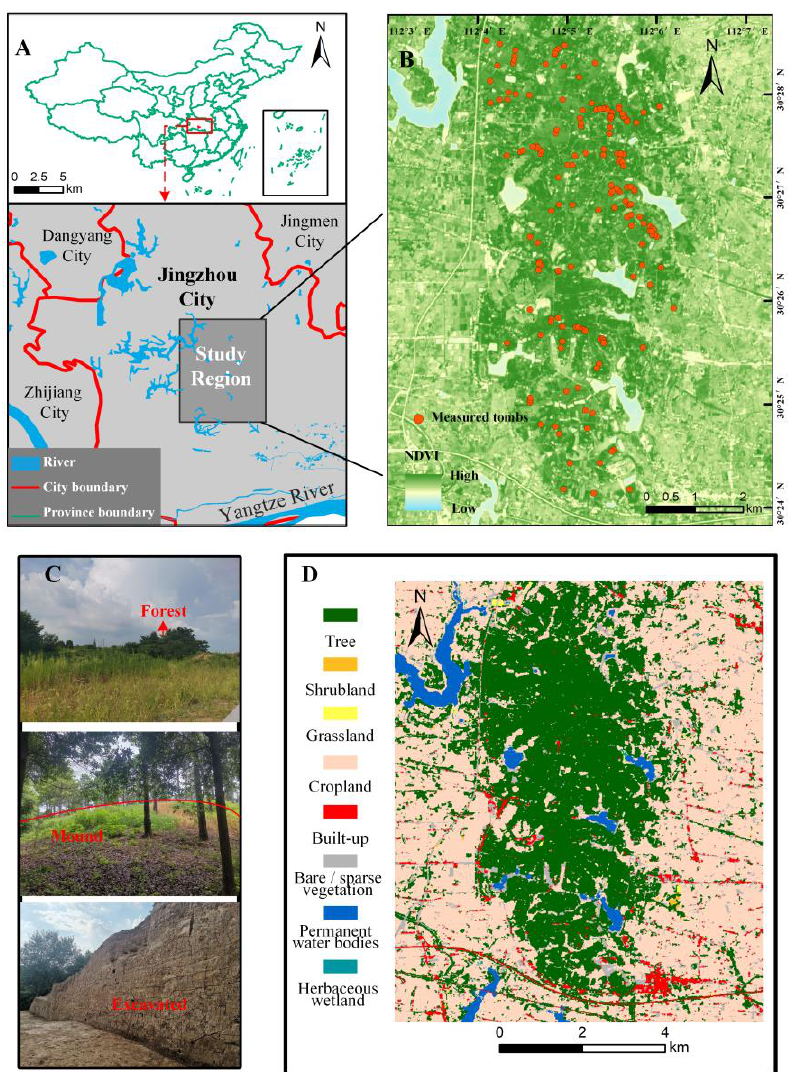
Figure 1. Location of the study area. ( A ) Situation of the study area in Jinzhou, and the situation of Jinzhou in China. ( B ) NDVI of study area and the distribution of confirmed ancient tombs. ( C ) Ancient tombs under the forest seen from the ground. Three pictures from top to bottom showing the ancient tombs are covered by forest, the uplifted state of the ancient tombs, and the structure of the ancient tomb. ( D ) This land cover map comes from the European Space Agency (https://developers.google.com/earth-engine/datasets/catalog/ESA_WorldCover_v200, accessed on 1 January 2020). Its name is World Cover 10 m 2020 product, and it provides a global land cover map for 2020 at 10 m resolution based on Sentinel-1 and Sentinel-2 data.